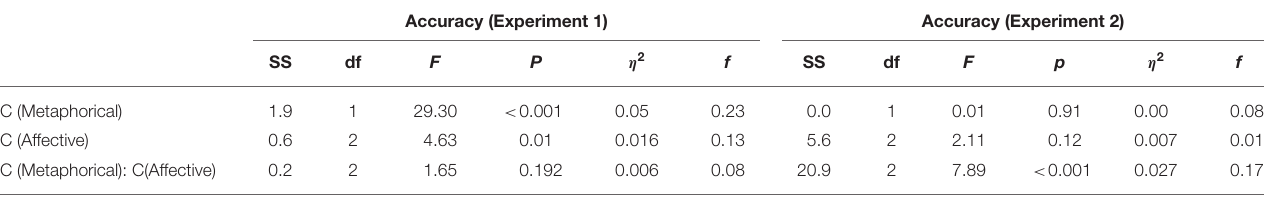
TABLE 3 | Main effects of metaphorical and affective middle term type for accuracy in Experiments 1 and 2.